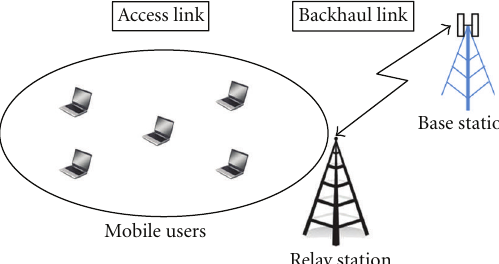
Figure 1: Relay station operation.